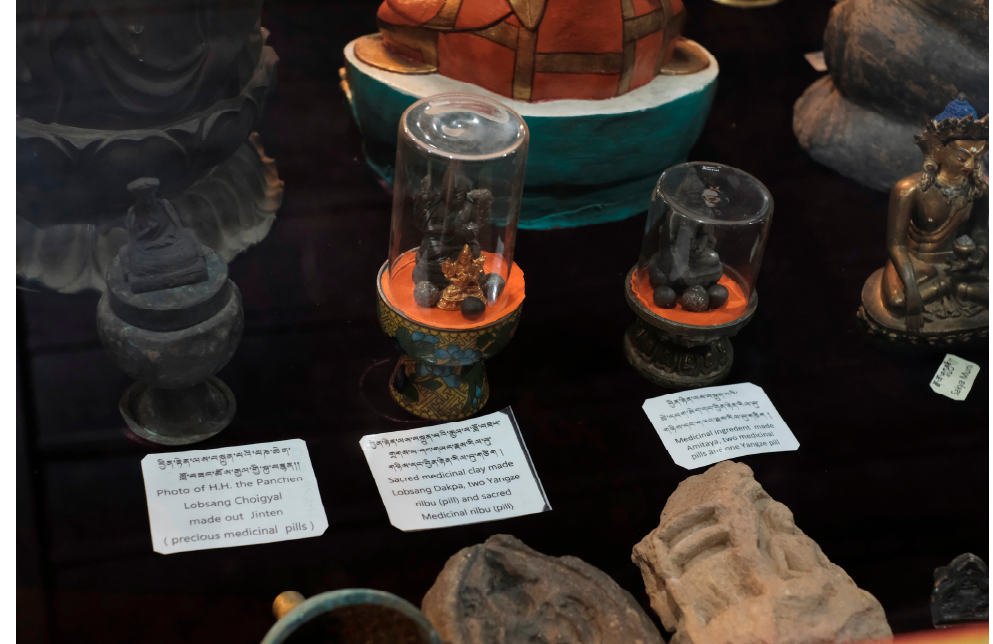
Figure 3. Three jinten -related exhibits at Tharpa Chöling Monastery Museum in Kalimpong. Left: A small statue made out of jinten material of Panchen Lozang Chögyel, probably referring to the first Panchen Lama (1570–1662). Middle: A statue made out of jinten material of Gyalwa Lozang Dakpa, referring to the founder of the Gelukpa school of Tibetan Buddhism, Tsongkhapa (1357–1419), with two yangdzé pills and one jinten pill as well as a tiny golden-colored statue of Tsongkhapa. Right: A statue made out of jinten material of Buddha Amit ā yus (Tshe dpag med), the Buddha of long life, with two jinten pills and one yangdzé pill in front. Note that my descriptions are based on the Tibetan exhibition labels, since their English translation is not always accurate. Kalimpong, December 2018. Photo by author.